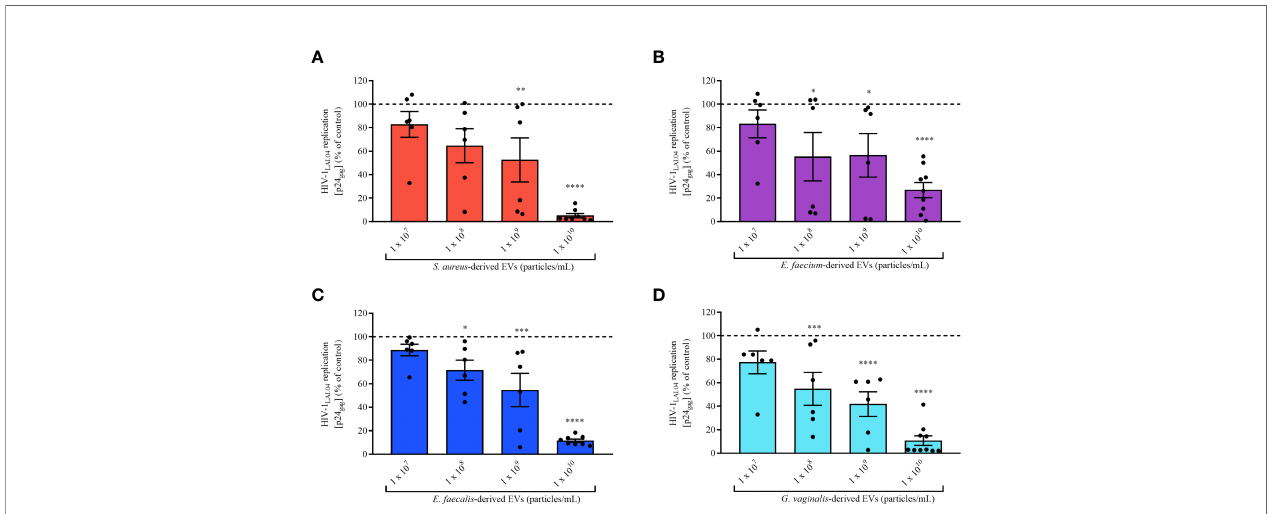
FIGURE 3 | Concentration effect of bacterial EVs on HIV-1 replication. MT-4 cells infected with HIV-1 Lai.04 were cultured in presence of bacterial EVs [ S. aureus (A) , E. faecium (B) , E. faecalis (C) , and G. vaginalis (D) ] at different EV concentrations, 1×10 7 , 1×10 8 , 1×10 9 , and 1×10 10 EVs/mL. After 3 days of culture, HIV-1 replication was evaluated from measurements of the concentration of p24 gag in the cell culture medium. The data are presented as percentages of HIV-1 replication compared with untreated controls. Presented are means±SEM from six independent measurements. Asterisks indicate statistical signi fi cance by one-way ANOVA multiple comparison with Dunnett ’ s correction (*p<0.05, **p < 0.01, ***p<0.001, ****p<0.0001).